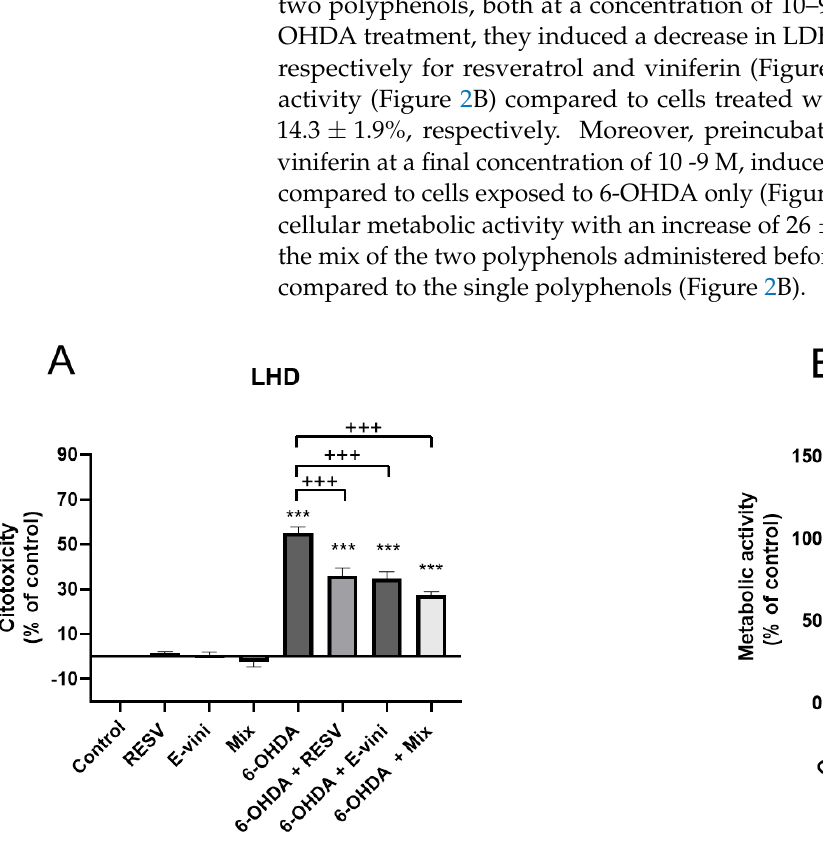
Figure 2. Levels of cytotoxicity ( A ) and metabolic activity ( B ) of PC12 neurons pretreated for three hours with culture medium (control), resveratrol, viniferin or a mixture of both polyphenols (Mix), all at a final concentration of 10–9. Cells were then treated with 6-hydroxydopamine (6-OHDA) at 50 µ M for 24 h, as described in the Material and Methods. The supernatants and the cells were used to perform cell death (lactate dehydrogenase (LDH) assay). Data are expressed as means ± SEM of five independent experiments. For each experiment, each condition was in assessed in sextuplicate. Asterisks (*) indicate statistical differences between the treatments and their respective controls (*** p < 0.001), plus signs (+) denote statistical differences between 6-OHDA and 6-OHDA in the presence of polyphenols (+++ p < 0.001, ++ p < 0.01,).